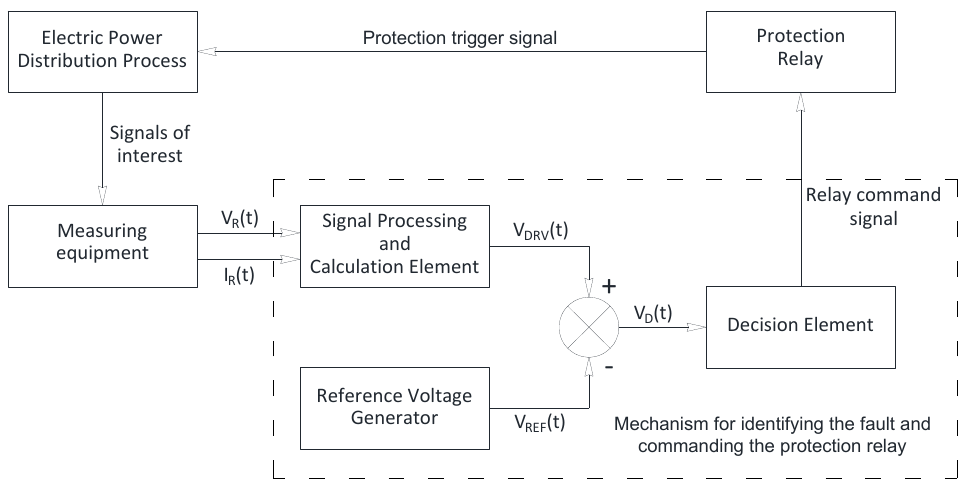
Figure 18. Automatic structure for rapid identification of fault occurrence and protection relay trig- gering.